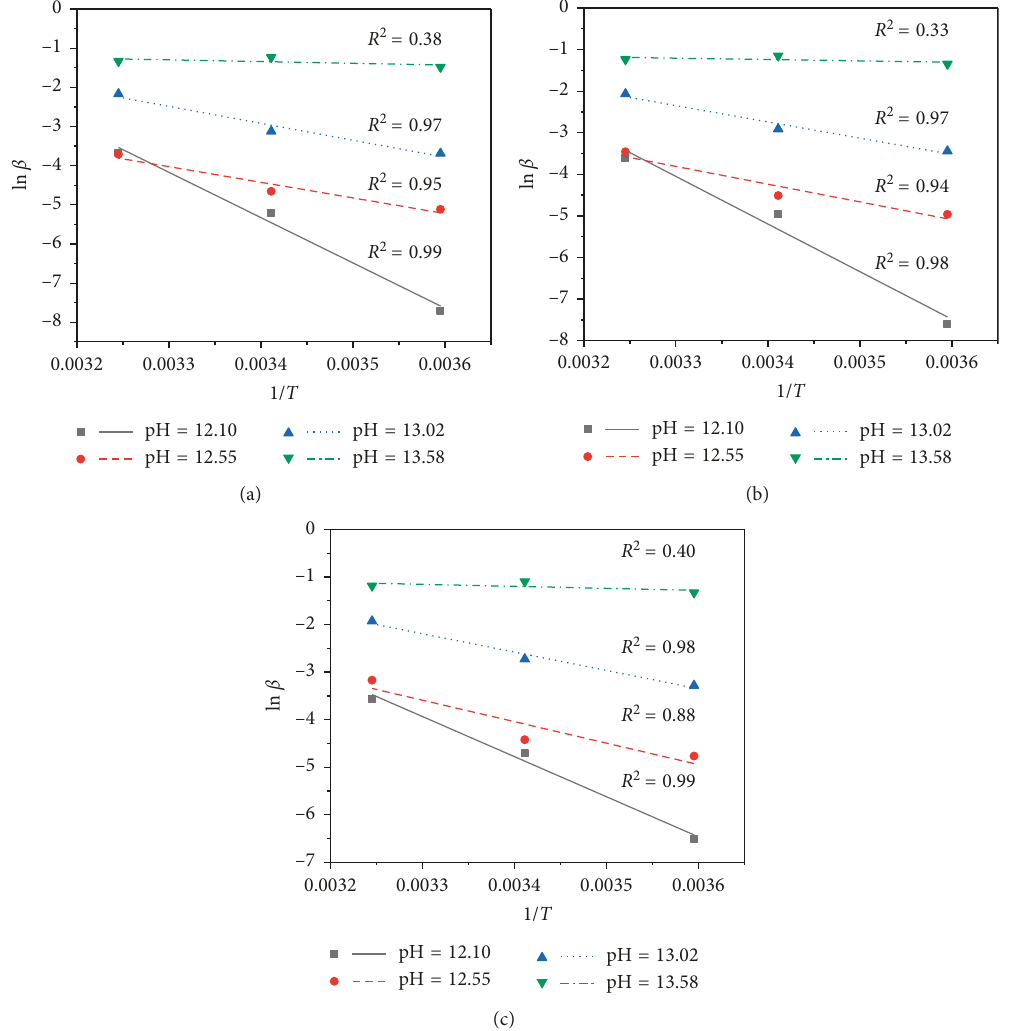
Figure 3: Effect of curing temperature on the hydration rate β at different w/s ratios for 1day: (a) w/s